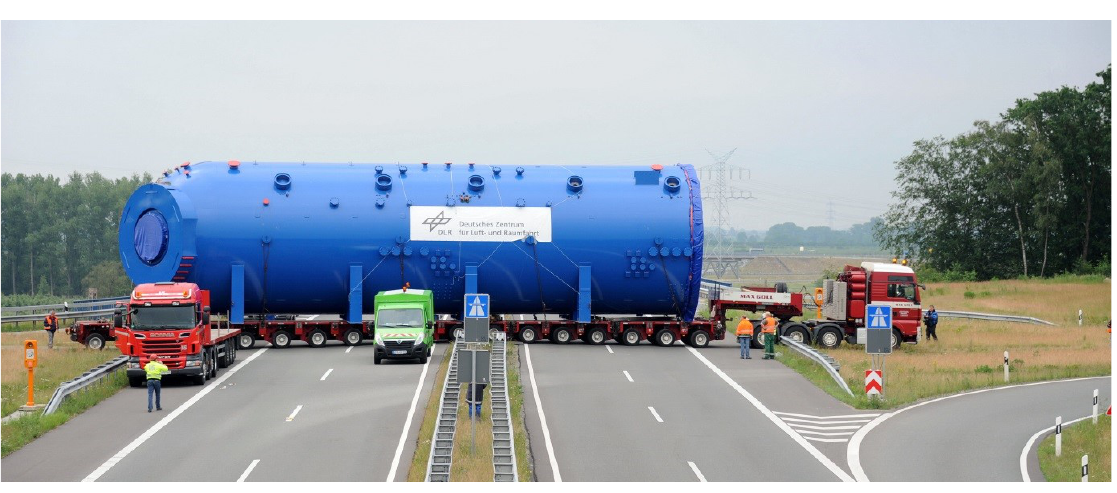
Figure 1: BALU - The research